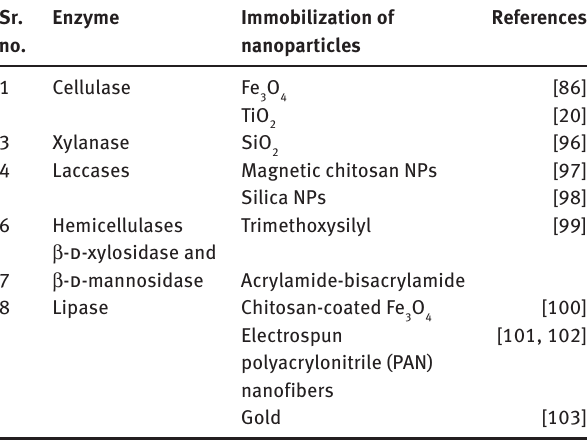
Table 3: Type of enzymes and respective nanoparticles on which they immobilized for ethanol or other bio-based